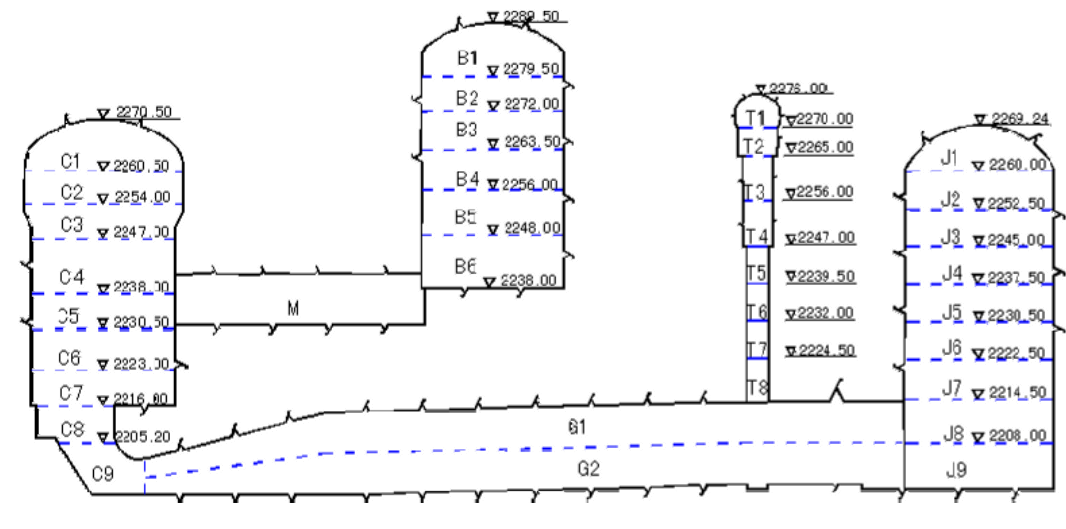
Figure 5. Divided layers of the Laxiwa underground